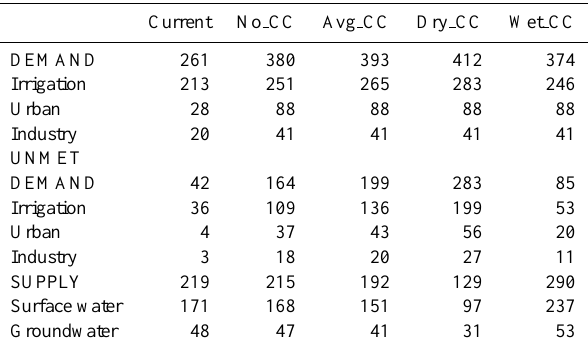
Table 1. Annual water supply and demand for the MENA region for current (2001–2010) and future (2041–2050) time frames. Fu- ture projections include ignoring climate change (No CC), and sce- narios for average, dry and wet projections. All numbers in km 3 per